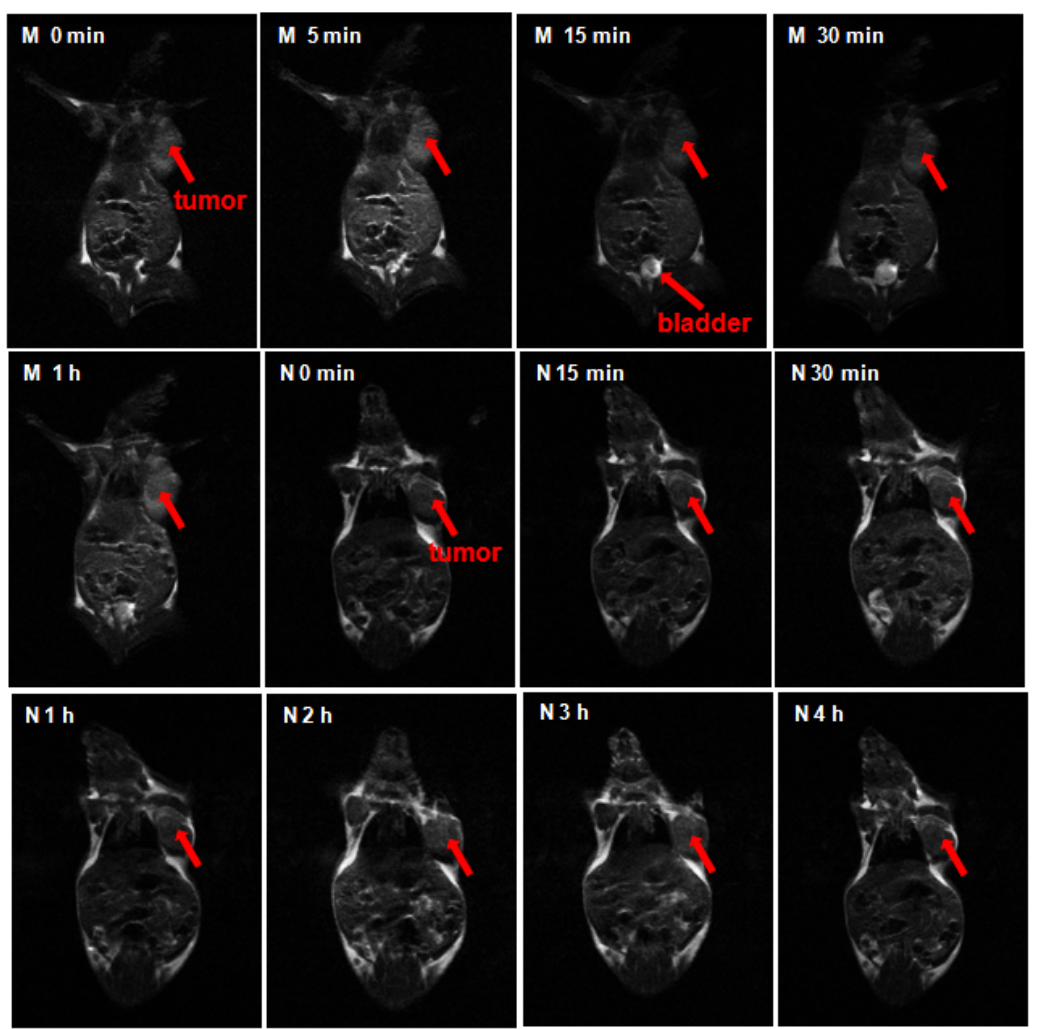
Figure 7. The MRI maps of mice after injected Magnevist (M) and GCHN